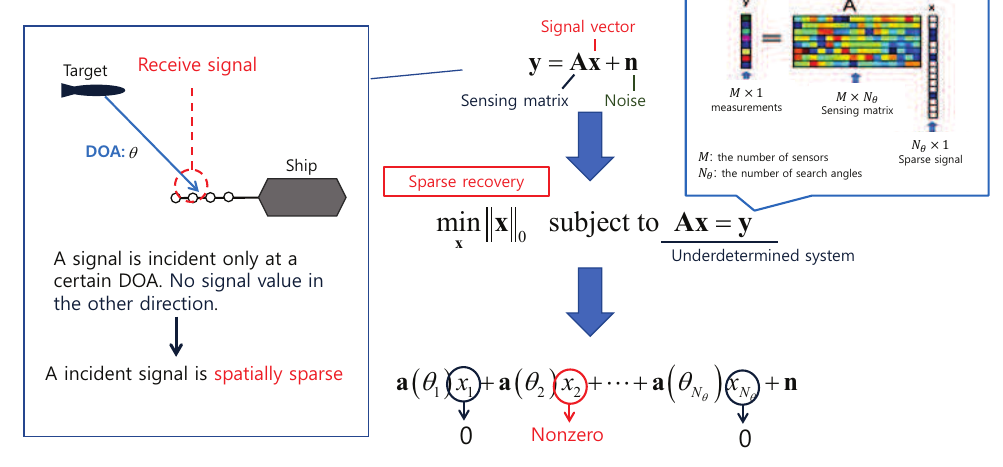
Figure 1. The concept of the compressive sensing-based DOA estimation